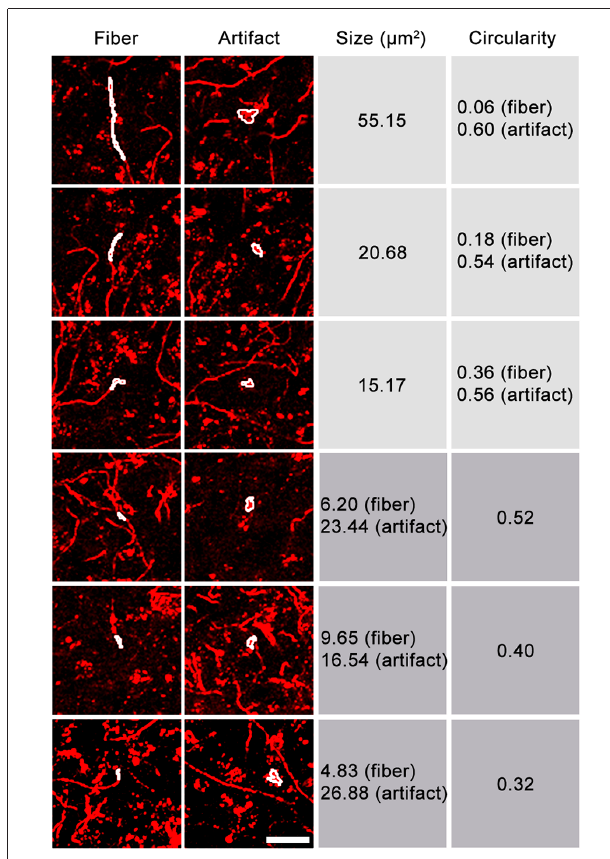
FIGURE 3 | Relationship between size and circularity of axonal fibers and fluorescent artifacts. Representative images contain Alexa Fluor 568 (tdTomato)-labeled axonal fibers and fluorescent artifacts, including autofluorescence. FIJI’s “Analyze Particles” function was used to identify fibers and fluorescent particles of equal size or equal circularity (white outlines). Fluorescent particles tend to exhibit higher circularity than fibers of equal size. Particles and short fiber segments of equal circularity are often different sizes. Considering both characteristics allows a greater proportion of fluorescent noise to be removed. Scale bar: 25 µ m. FIGURE 4 | DEFiNE processing of z-stack images allows for maximal